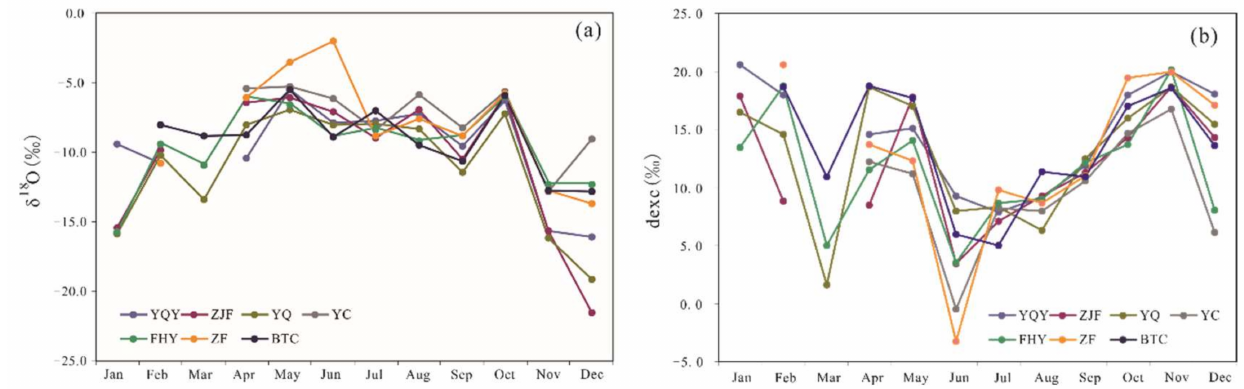
Figure 3. Seasonal variations in ( a ) δ 18 O and ( b ) d-excess at seven stations in Beijing in 2015.